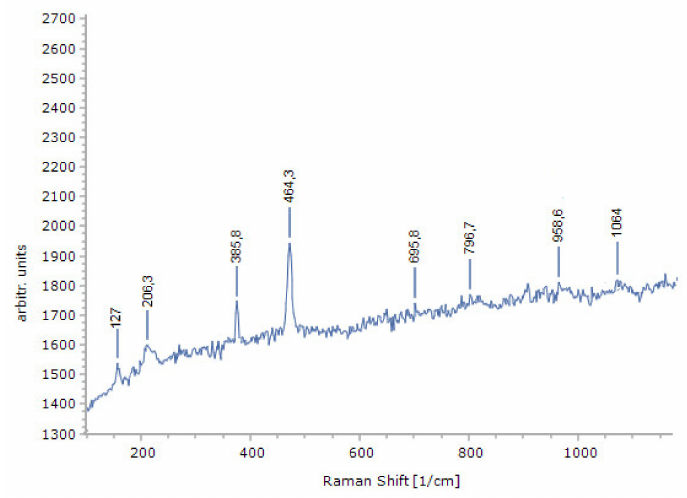
Figure 10. The Raman spectrum obtained during the irradiation of a chalcedonite sample from the first jig product with shift